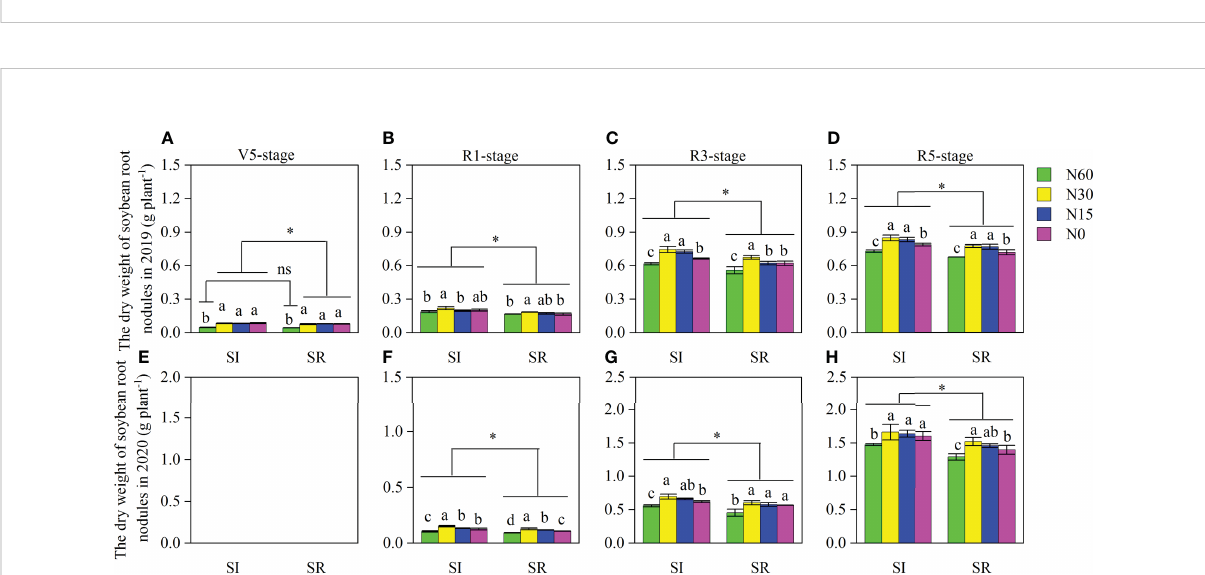
FIGURE 5 Effects of straw incorporation and N application on root nodule dry weight of intercropped soybean at different growth stages. Due to the small number of nodules per plant and small nodule diameter at the V5 stage in 2020, the nodule weight was not measured. Different lower-case letters indicate signi fi cant differences under different N application rates (LSD, P < 0.05). The asterisk “ * ” and “ ns ” indicate signi fi cant differences ( P < 0.05) and insigni fi cant differences ( P >0.05) between straw incorporation and straw removal, respectively. Data were shown as mean ±